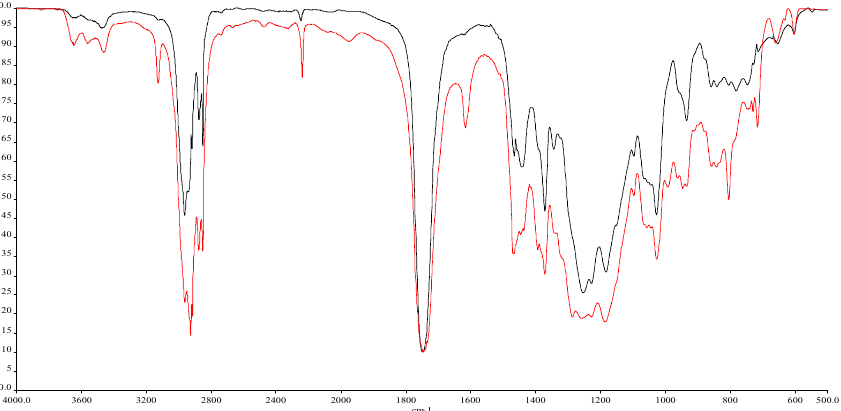
Figure 2. IR spectra of the adhesive before (t = 0, red line) and after t = 6 h (black line) of polymerization. Table 1. Spectrum interpretation for Loctite ® Super Attak Glass adhesive.